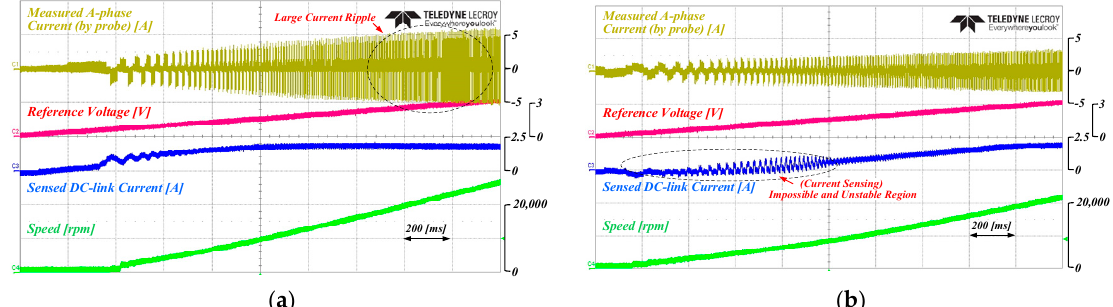
Figure 11. Experimental results using single PWM method: ( a ) H-PWM-L-ON method; and ( b ) H-PWM-L-PWM method.